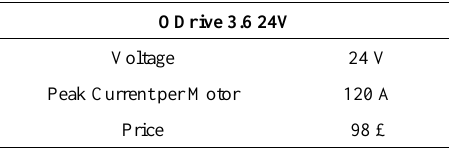
Table 4. The main characteristics of the driver